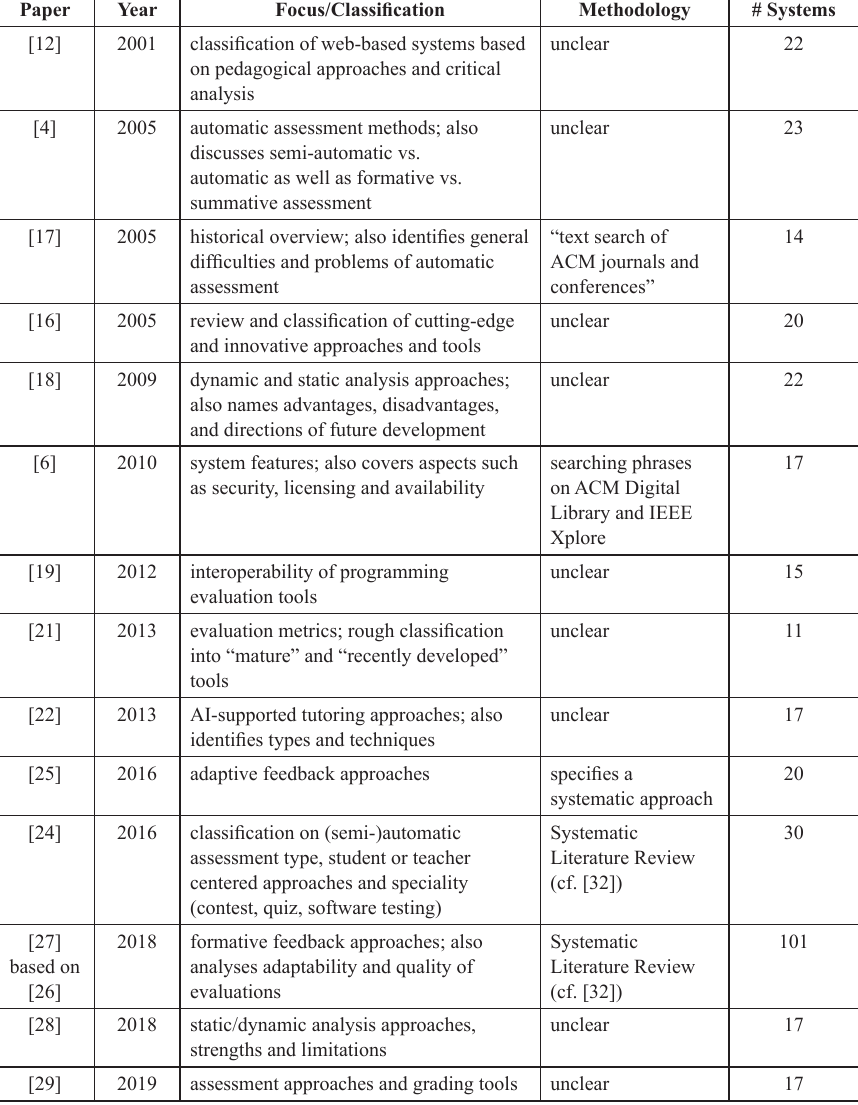
Table 1. Focus of existing review and survey papers with a focus on tools, based on an analysis in